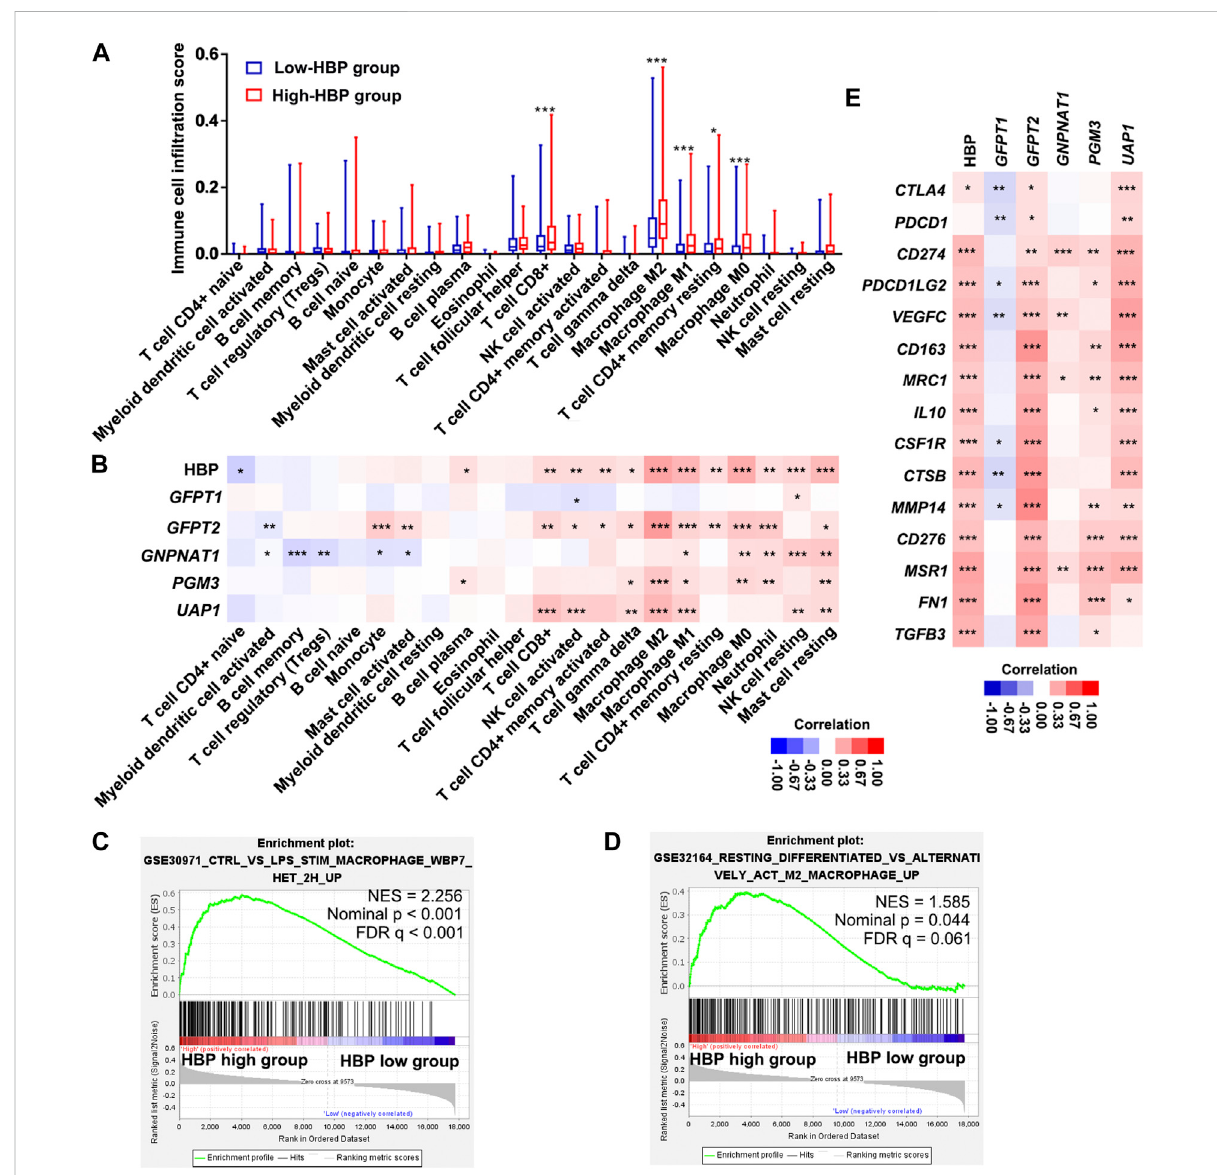
FIGURE 6 HBPwaspositivelycorrelatedwiththein fi ltrationofmacrophagesinTCGA-BLCAdataset. (A) Thein fi ltratingestimationfractionofimmunecell inlow-andhigh-HBPsignaturegroups. (B) Heatmapfortheassociationsbetweenthein fi ltratingestimationfractionandHBPscoreormRNAlevelof each HBP member in different immune cell types. (C,D) The associations between HBP signature and macrophage signaling (C) or M2 macrophage signaling (D) in TCGA-BLCA dataset by GSEA. In the enrichment plot, genes were ranked by signal/noise ratio according to their differential scores between low- and high-HBP signatures. (E) Heatmap for the associations between M2 macrophage-associated genes expression and